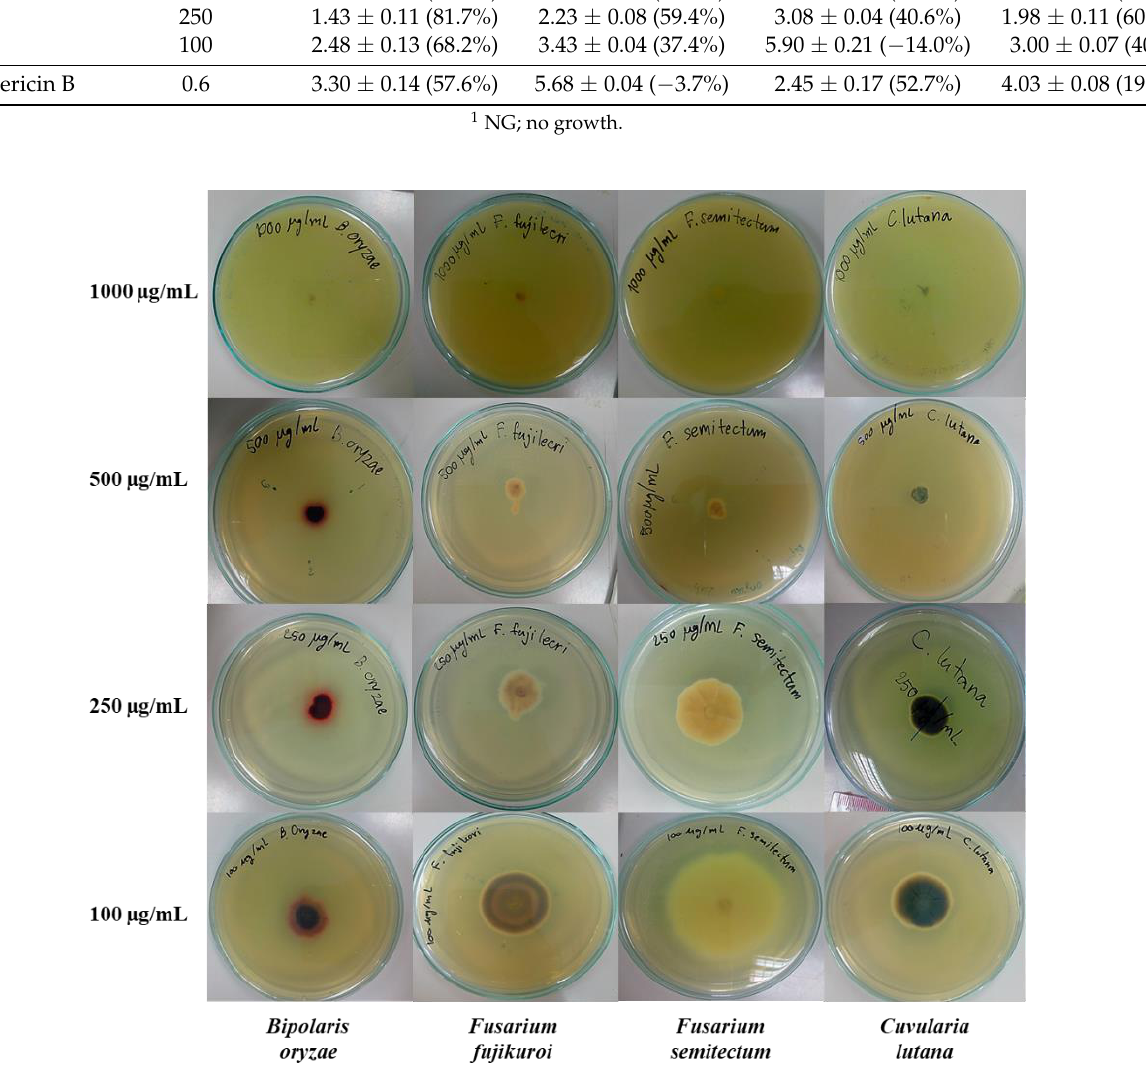
Figure 2. Inhibitory activity of ( 3g ) against a diameter of a colony of phytopathogenic fungi.